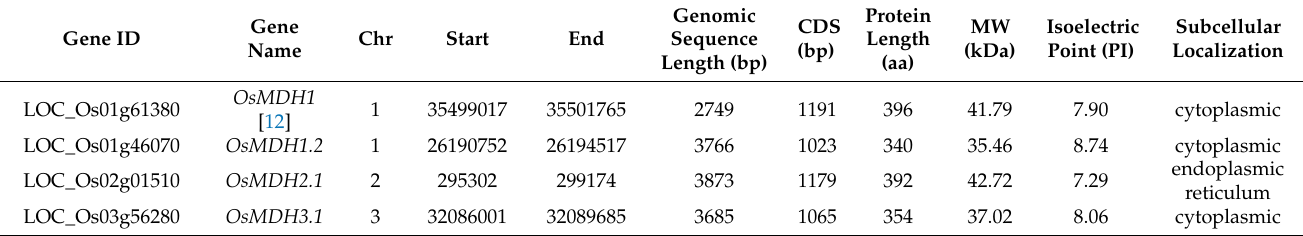
Table 1. Basic information of MDH gene family in